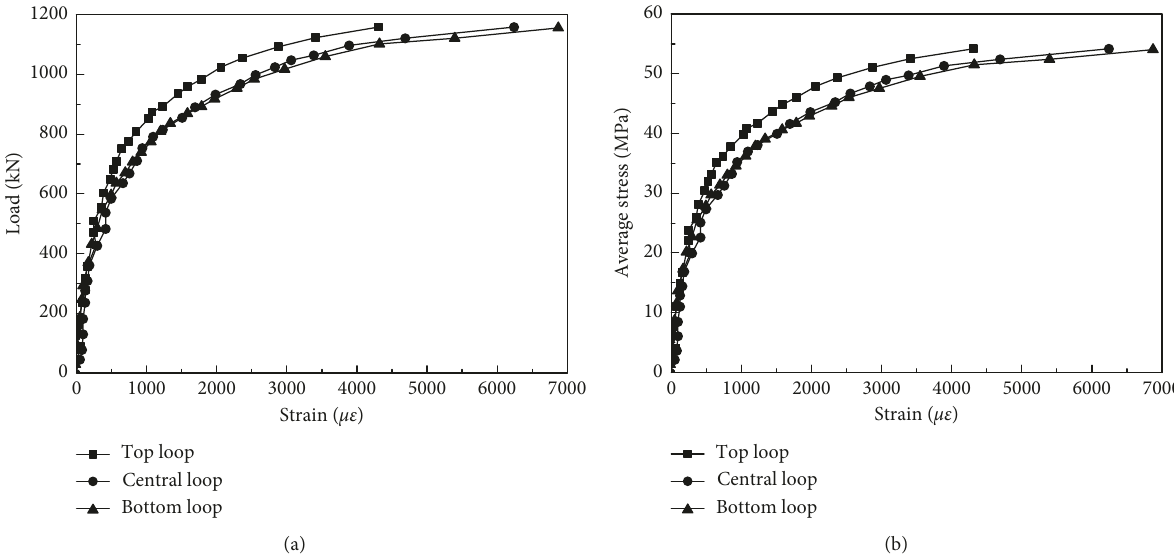
Figure 15: Loop strain development of specimen RS-B-2 with steel casing. (a) Relationship of strain development with load. (b) Relationship of strain development with average stress.